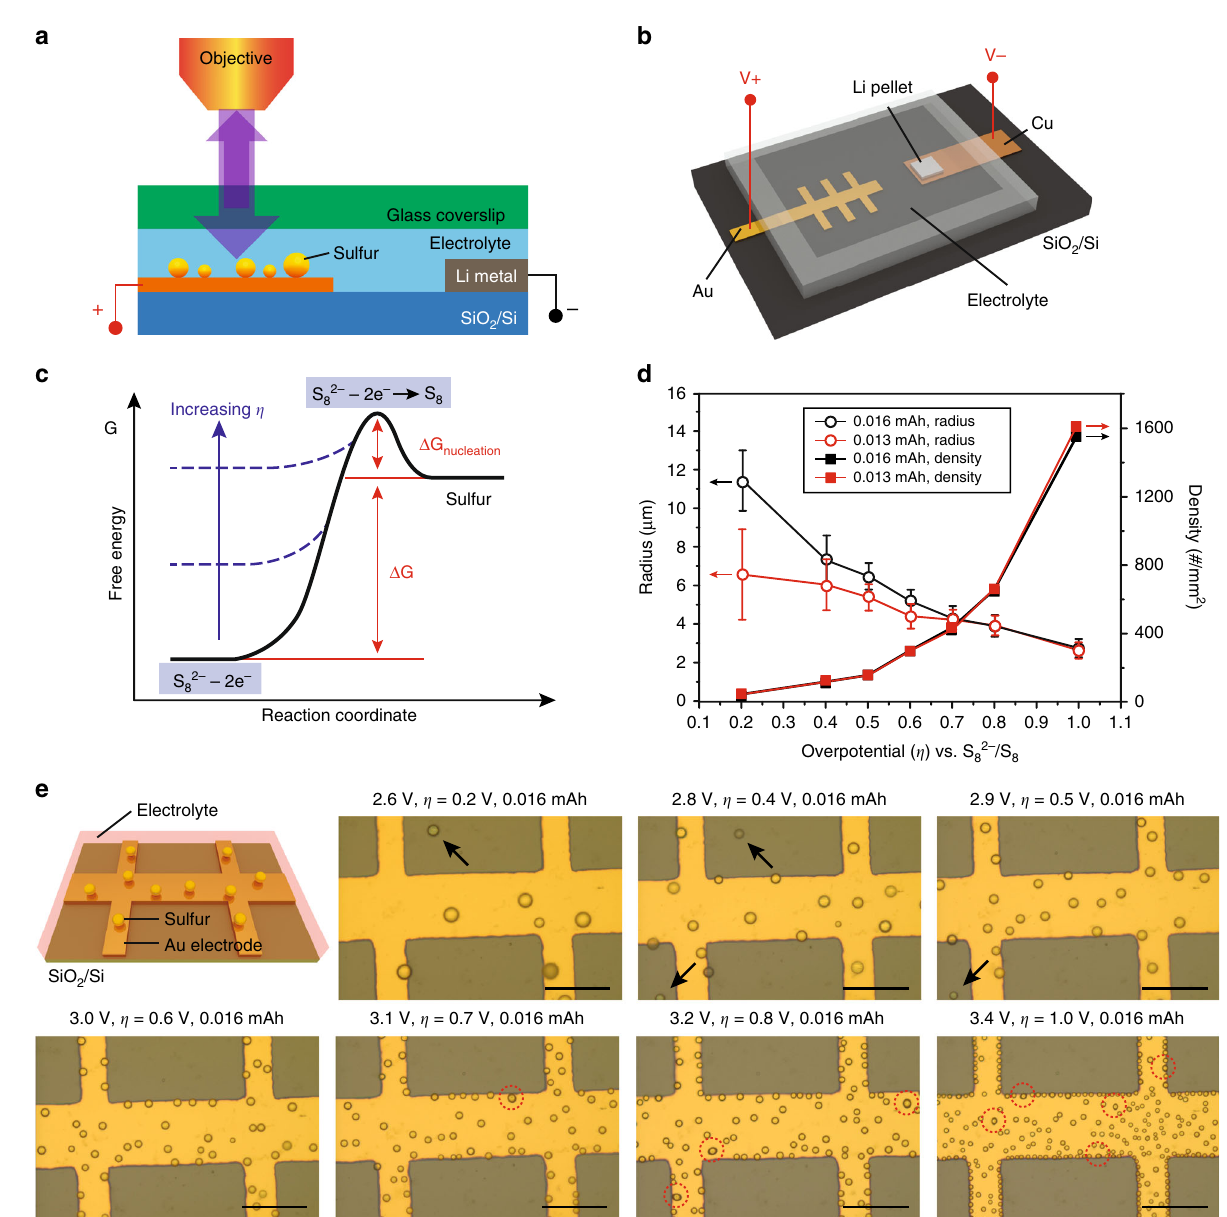
Fig. 1 In situ observation of sulfur nucleation. a Schematic of the setup for the in situ optical observation. b Schematic of the assembled electrochemical device. c Free energy schematic showing the effects of increasing overpotential ( η ) on the energy barrier for sulfur nucleation. d Plot of sulfur droplet radius and density versus overpotential ( η ) at capacities of 0.013 and 0.016 mAh. Radius is measured for sulfur droplets after charging 0.013 and 0.016 mAh. e Optical images of sulfur droplets produced at different overpotentials with a fi xed total charge capacity of 0.016 mAh. Scale bar in ( e ) is 100 μ